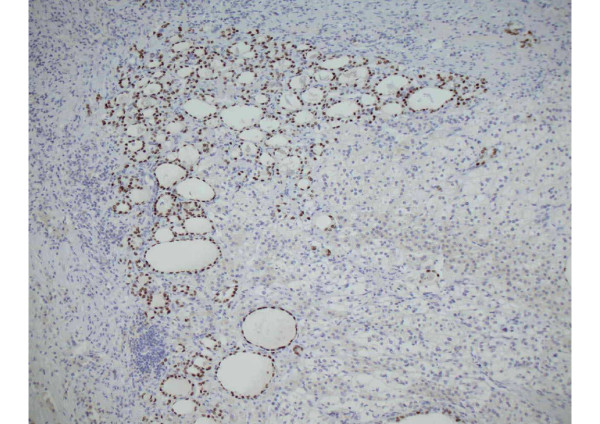
TTF-1 stain is positive for the epithelial cells.